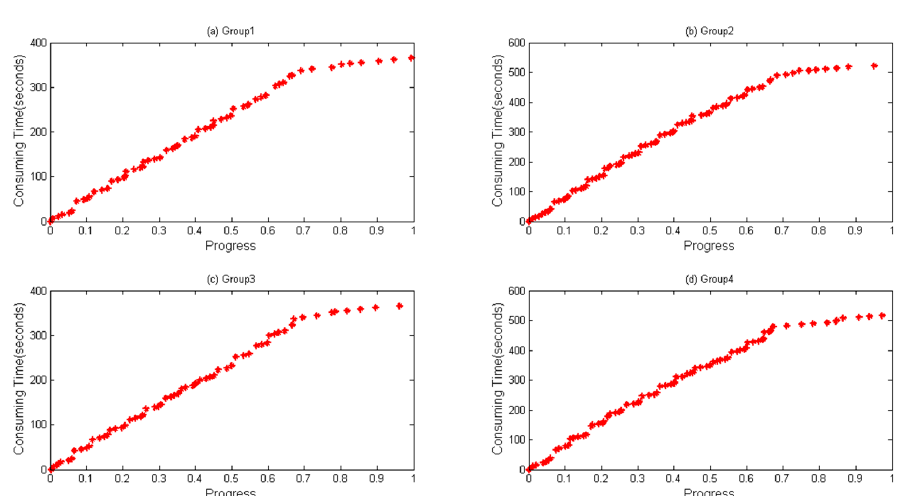
Figure 2. Data collected during running WordCount on the same node. Different groups of data generated from four map tasks running on the same node when executing WordCount: ( a ) Group 1; ( b ) Group 2; ( c ) Group 3; and ( d ) Group 4.